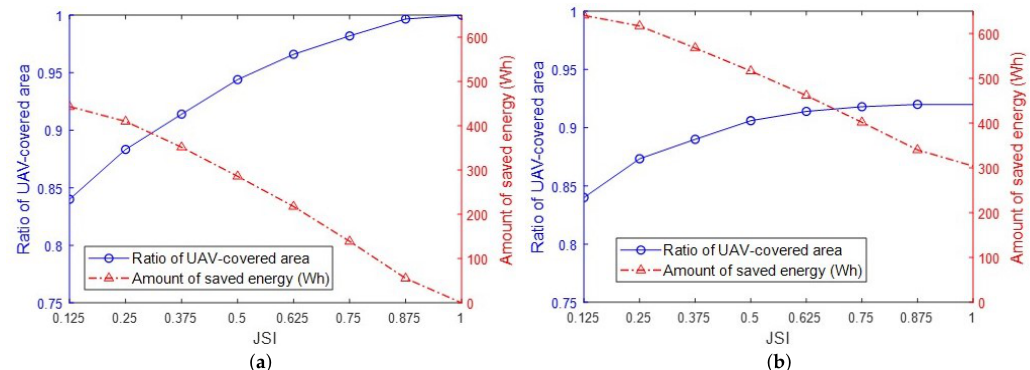
Figure 5. Trade-off between the ratio of the UAV-covered surveillance area and the amount of saved energy of the proposed EE algorithm (Scenario 3). ( a ) For 40 min. ( b ) For 60